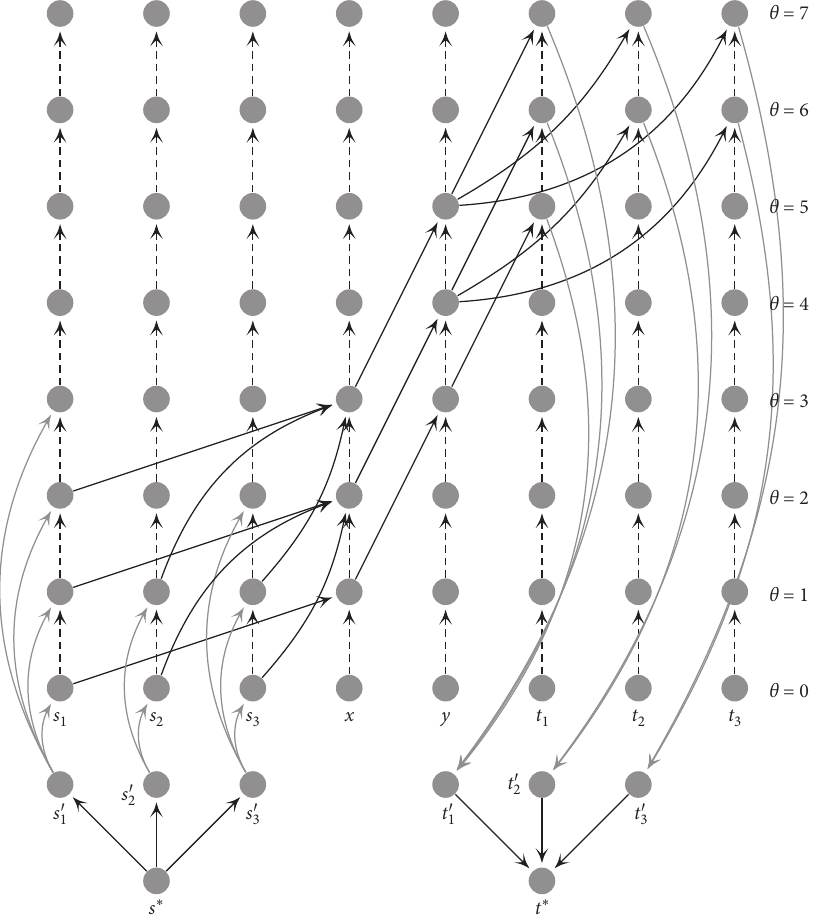
Figure 4: Time-expanded network of Figure